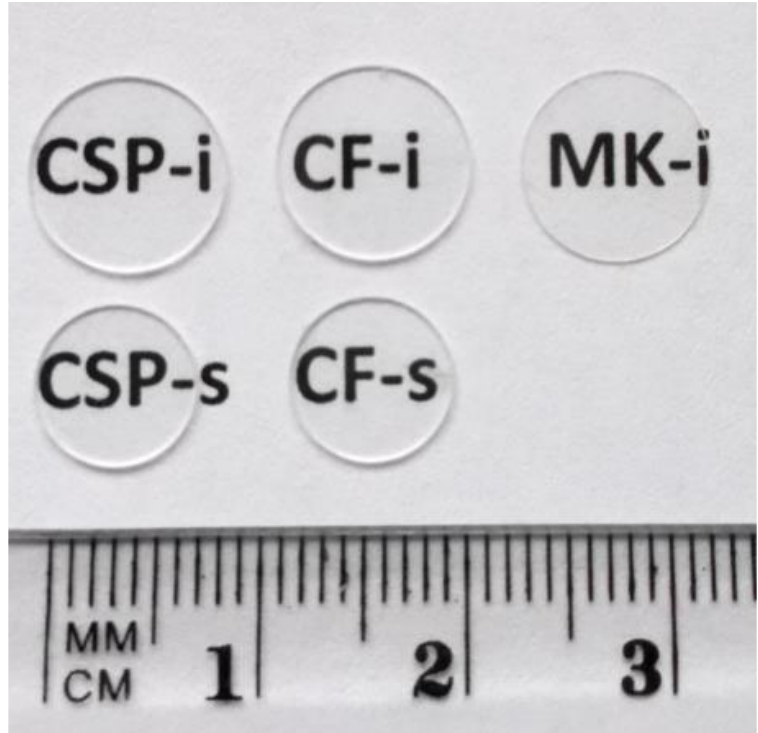
Figure 1. Photos of tested camera lens glass protectors with markings.